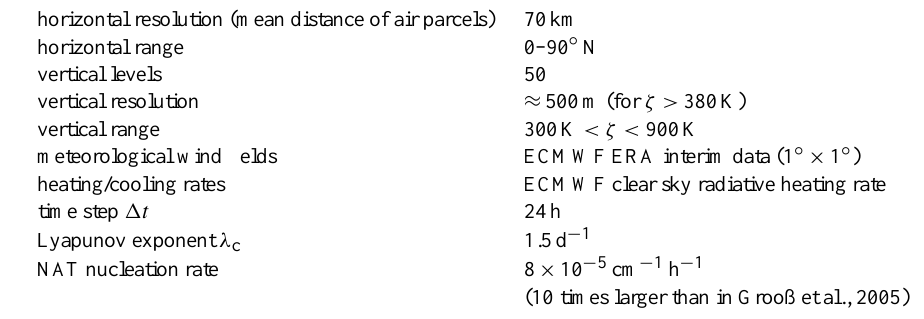
Table 2. Summary of the CLaMS setup.